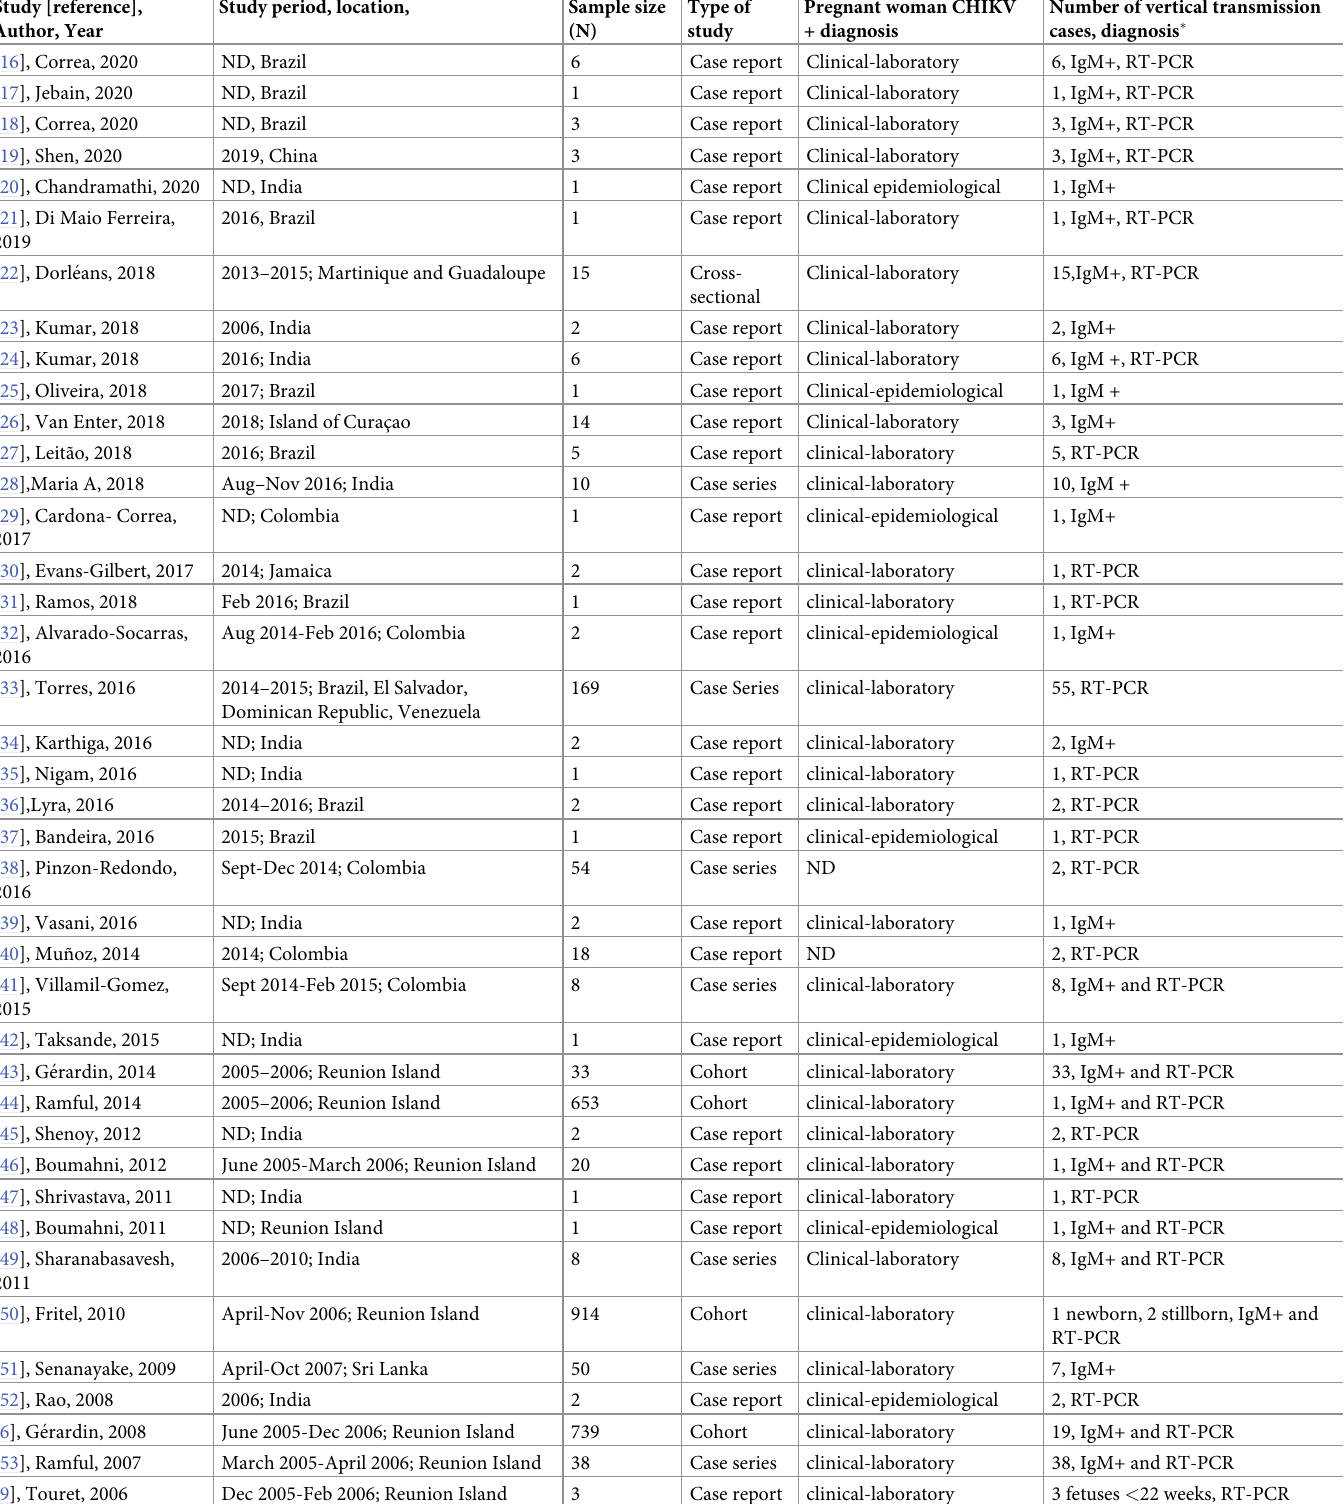
Table 1. Characteristics of included